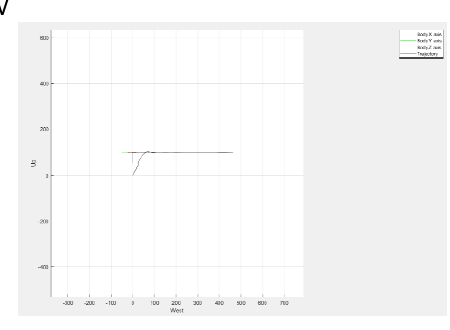
Figure 23. U linear velocity response for the QAV